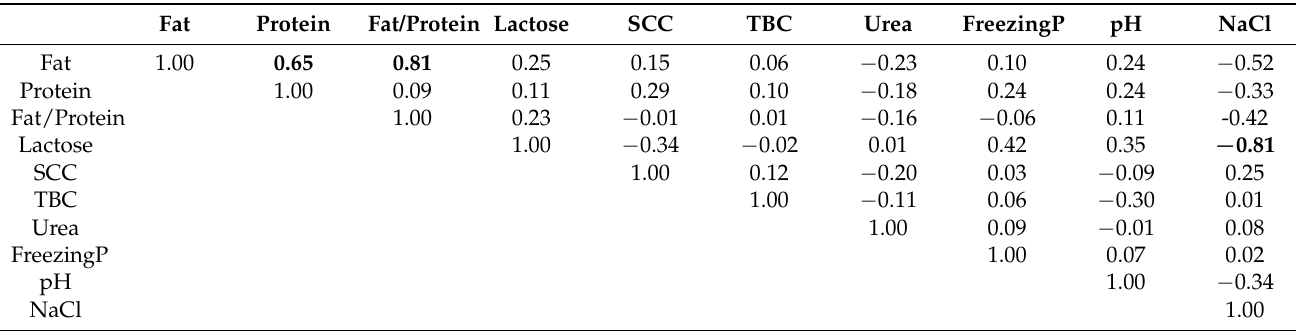
Table 2. Correlation matrix between main milk components for Sarda and Saanen milk samples. Values > 0.60 are in bold.